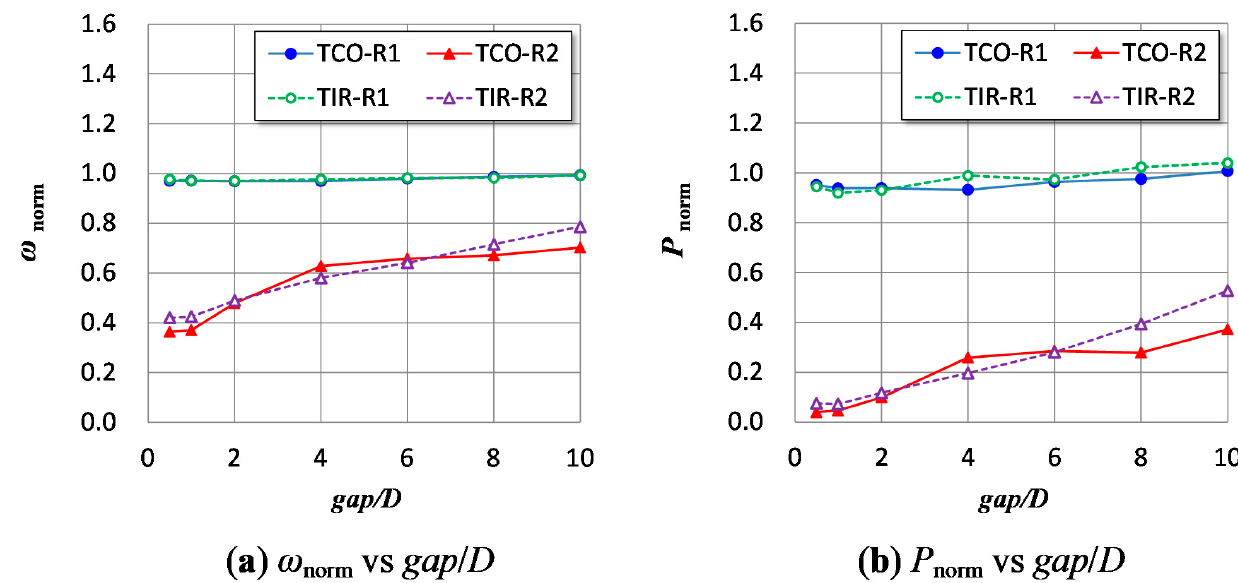
Figure 12. Gap dependence of ( a ) normalized angular velocity and ( b ) normalized power of each rotor in tandem layouts.